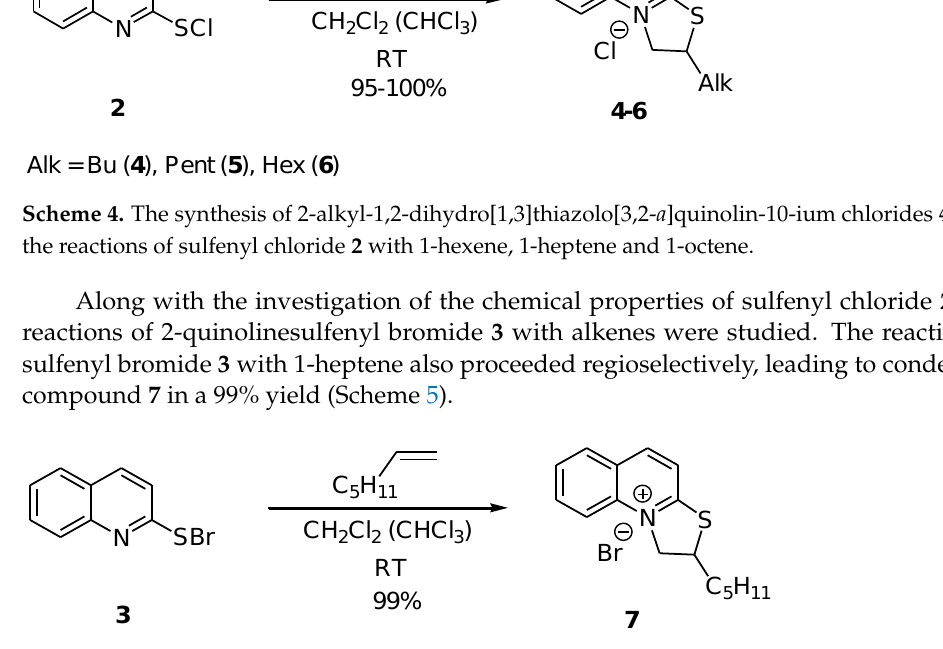
Scheme 5. The synthesis of 2-pentyl-1,2-dihydro[1,3]thiazolo[3,2- a ]quinolin-10-ium bromide 7 by the reactions of sulfenyl bromide 3 with 1-heptene.